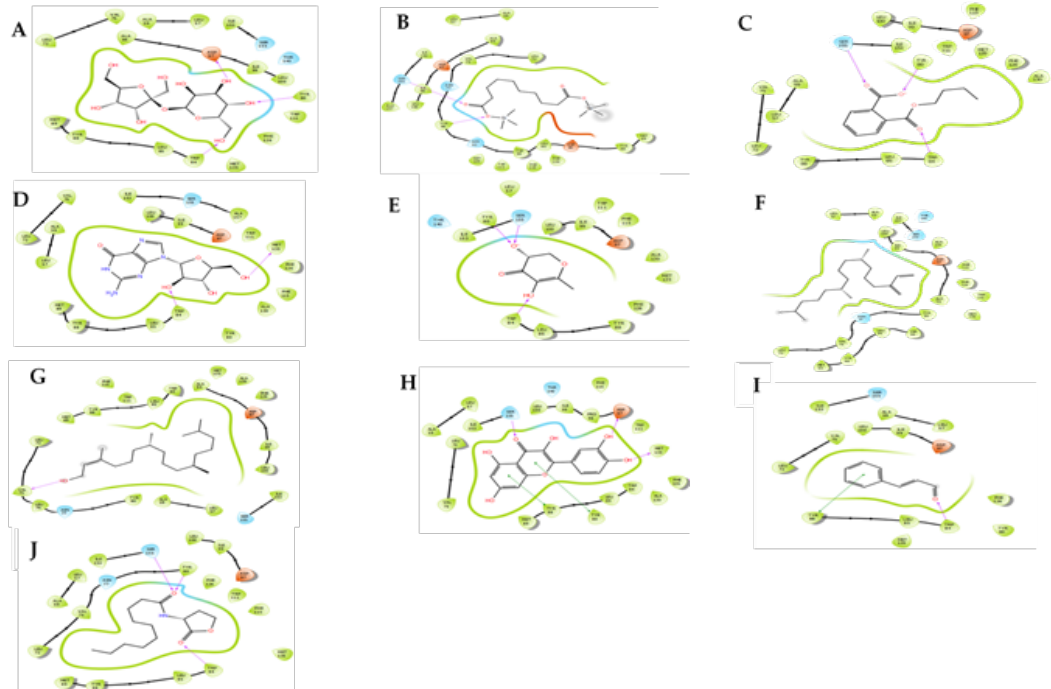
Figure 2. Interaction network between 3QP1 protein and the studied compounds. The protein residues with a negative charge are shown in red, positive charge in velvet, polar in cyan, and hydrophobic in parrot green. The H-bond interactions are shown as a purple arrow, pi-pi stacking as a green line. ( A ) Sucrose; ( B ) decanedioic acid; ( C ) 1,2-benzenedicarboxylic acid; ( D ) guanosine; ( E ) 2.3-dihydro-3.5-dihydroxy-6-methyl-4H-pyran-4-one; ( F ) neophytadiene; ( G ) phytol; ( H ) quercetin; ( I ) cinnamaldehyde and ( J ) C10-homoserinelactone.